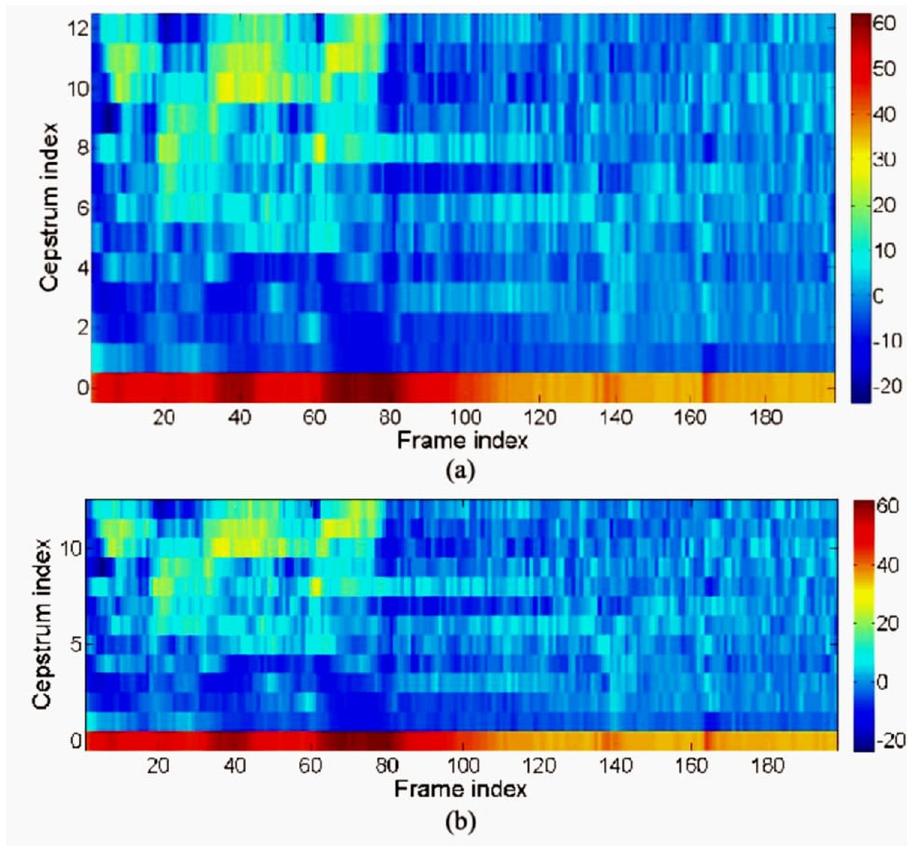
Figure 4: The MFCC of normal and pathological voice samples [ 5 ]